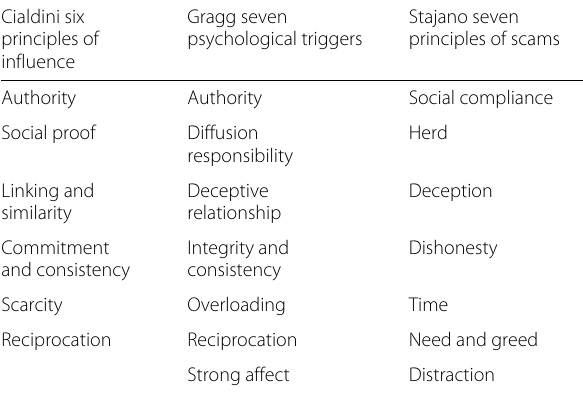
Table 1 Cialdini, Gragg, and Stajano principles (Ferreira et al. 2015; Caulkins